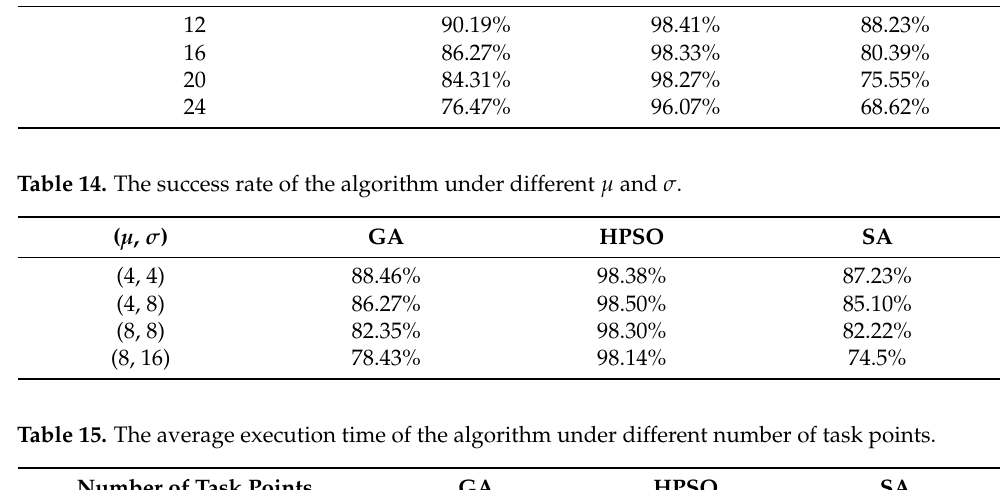
Table 13. The success rate of the algorithm under different number of task points. Number of Task Points